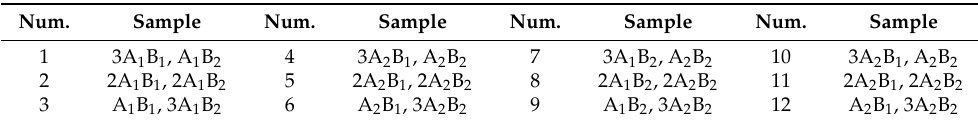
A 1 B 2 A 2 B 2